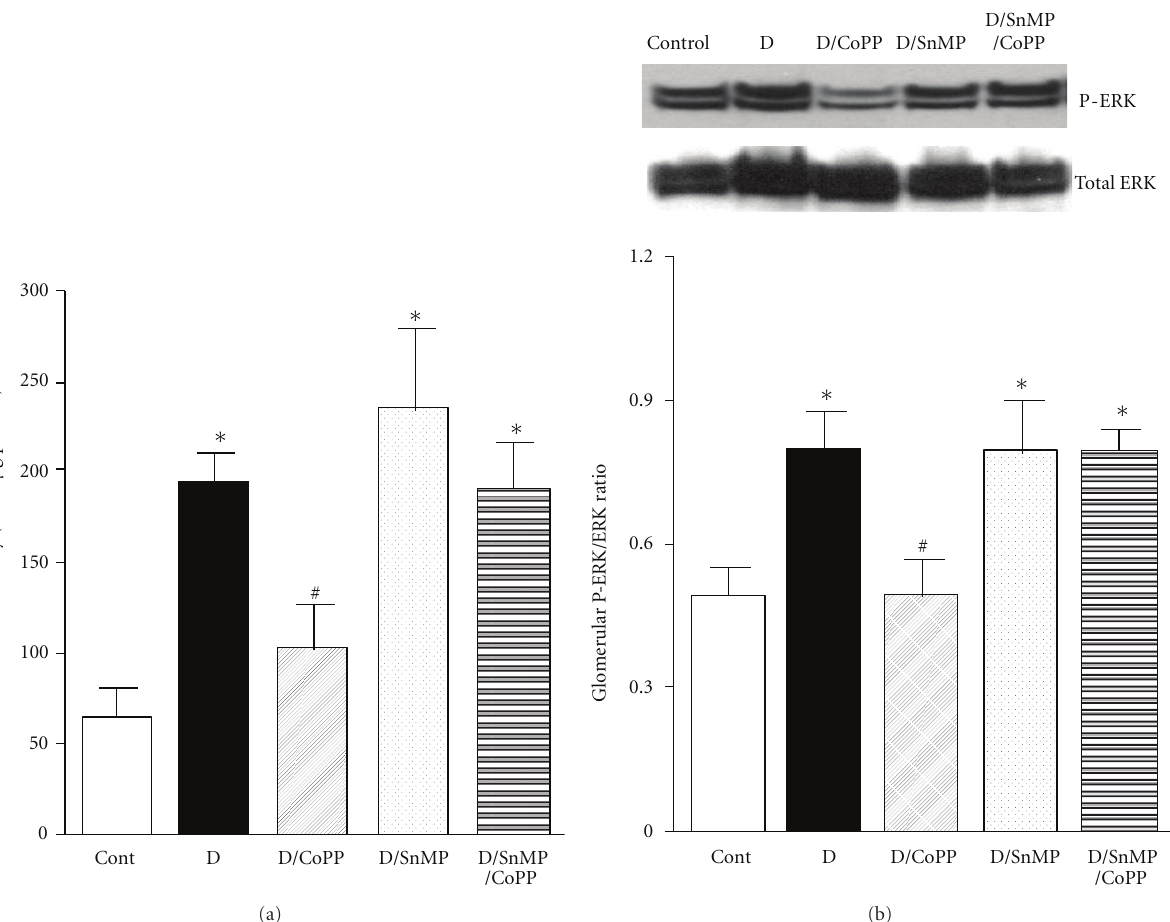
Figure 7: NADPH oxidase activity (a) and P-ERK/ERK ratio (b) in glomeruli isolated from control and diabetic SHR and incubated with or without CoPP and/or SnMP for 2 hours at 37 ◦ C ( n = 4, Cont is an abbreviation for control SHR and D is an abbreviation for diabetic SHR, ∗ indicates significant di ff erence from control SHR, # indicates significant di ff erence from diabetic